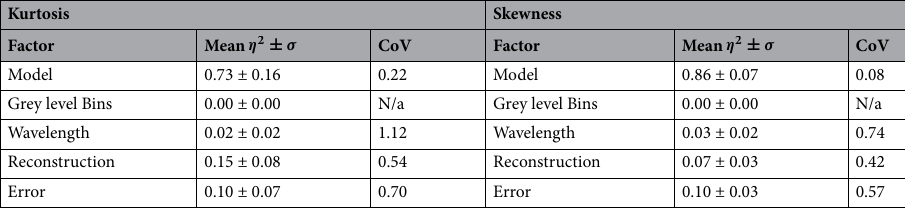
Table 2. Results of five fold validation for Kurtosis and Skewness σ is the standard deviation, and due to rounding error CoV values may not match exactly with mean and standard deviation values present. As grey level binning has practicably no effect on these metrics the CoV calculation was not deemed applicable. Mean values are not expected to precisely match with those in Fig. 2 due to the variation in the sampling distribution, but rather to lie within the interval suggested by the standard